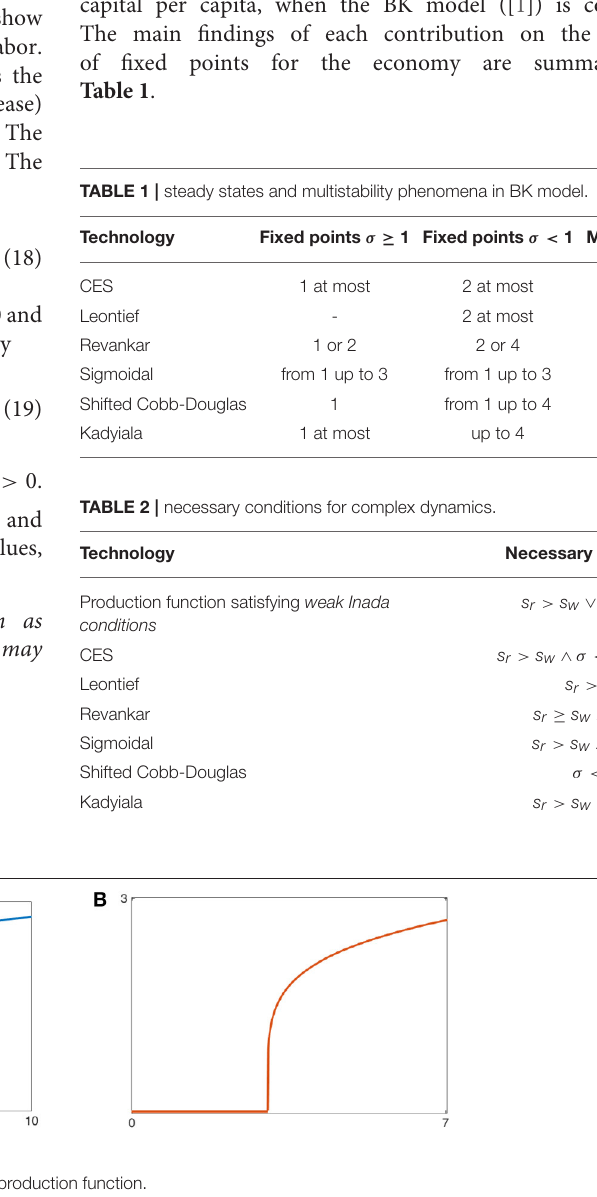
FIGURE 3 | (A) Sigmoidal production function. (B) Shifted Cobb-Douglas production